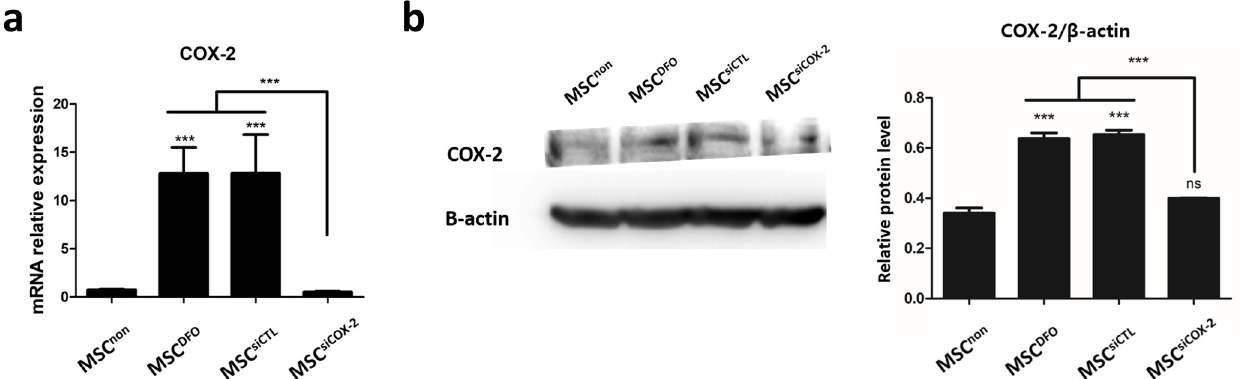
Fig 2. The expression levels of COX-2 in cAT-MSC DFO . (a) The mRNA level of COX-2 is increased in DFO preconditioned and treated with siCTL group. However, COX-2 is not increased in transfected with siCOX-2 group. (b) The protein level of COX-2 is increased in DFO preconditioned and decreased in transfected with siCOX-2 group, same as mRNA result. Results are shown as means ± standard deviation. ��� P < 0.001. ns, not significant.